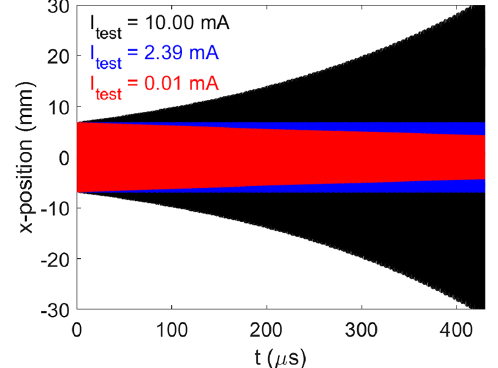
respectively.FIG. 5. Particle x-position (in the cavity) when test currents I is above (black), below (red), and at (blue) the threshold